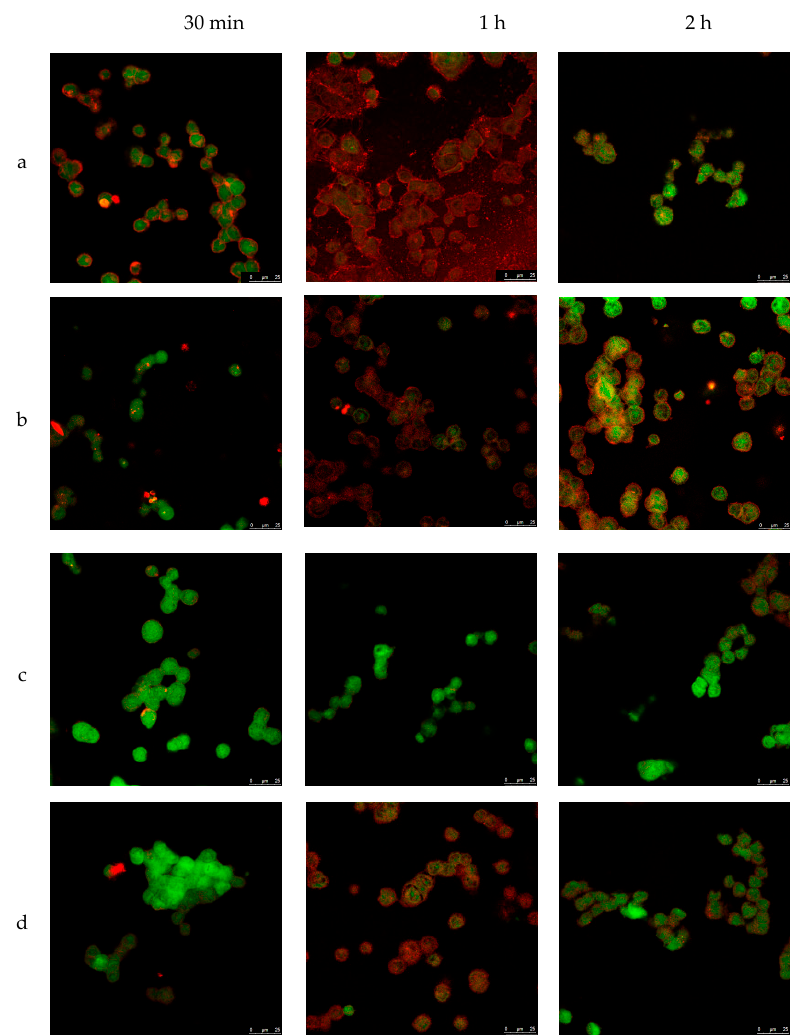
Figure 5. Microscopy confocal images of TC28a2 chondrocyte cells (green) incubated with enzyme-NLC (red) at 37 °C. ( a ) 200 mg/mL, ( b ) 100 mg/mL, ( c ) 50 mg/mL, and ( d ) 25 mg/mL.